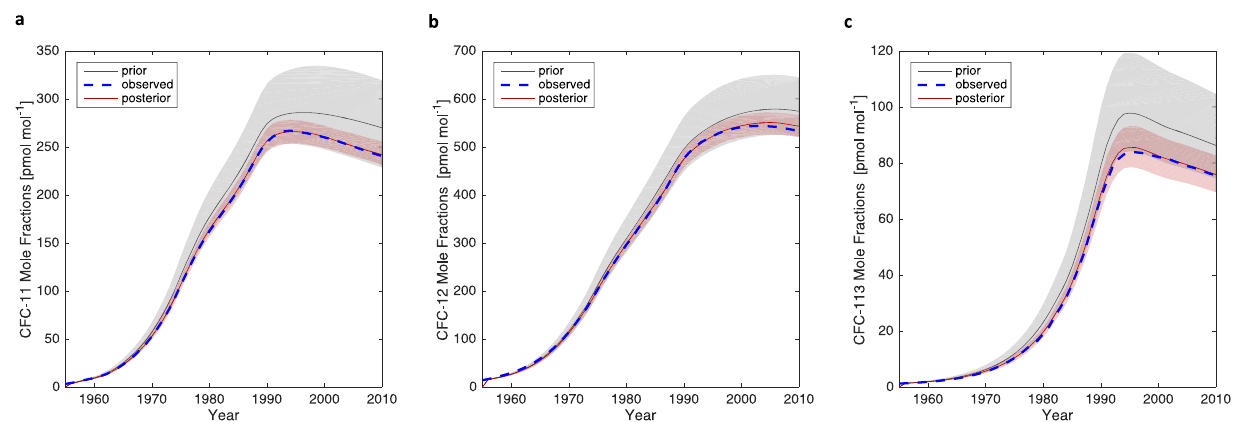
Fig. 2 Mole fraction estimates. The grey line and shaded region indicate median and 95% CI of the prior distribution for ( a ) CFC-11 ( b ) CFC-12, and ( c ) CFC-113. The dashed blue lines are observed concentrations and the red line and shaded region indicate the median and 95% CI for the